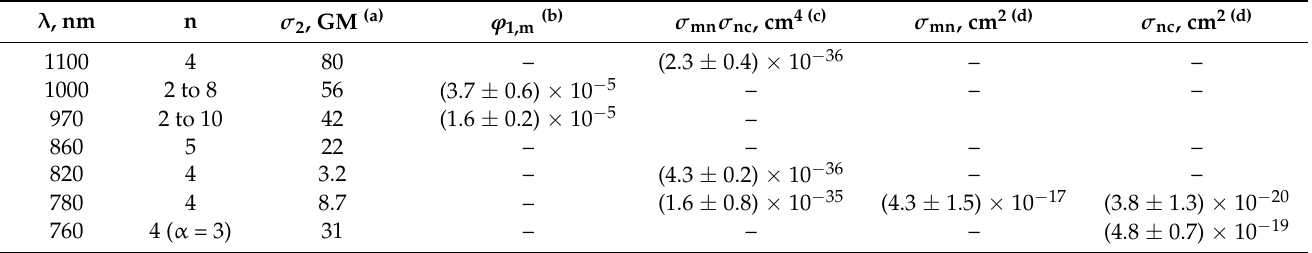
Figure 9. Power dependences of the bleaching rates of tdTomato at different wavelengths (see legends in the insets) presented in double logarithmic scale. ( a ) Long wavelength range; ( b ) Short wavelength range. Table 4. Molecular photobleaching parameters of tdTomato at different wavelengths.